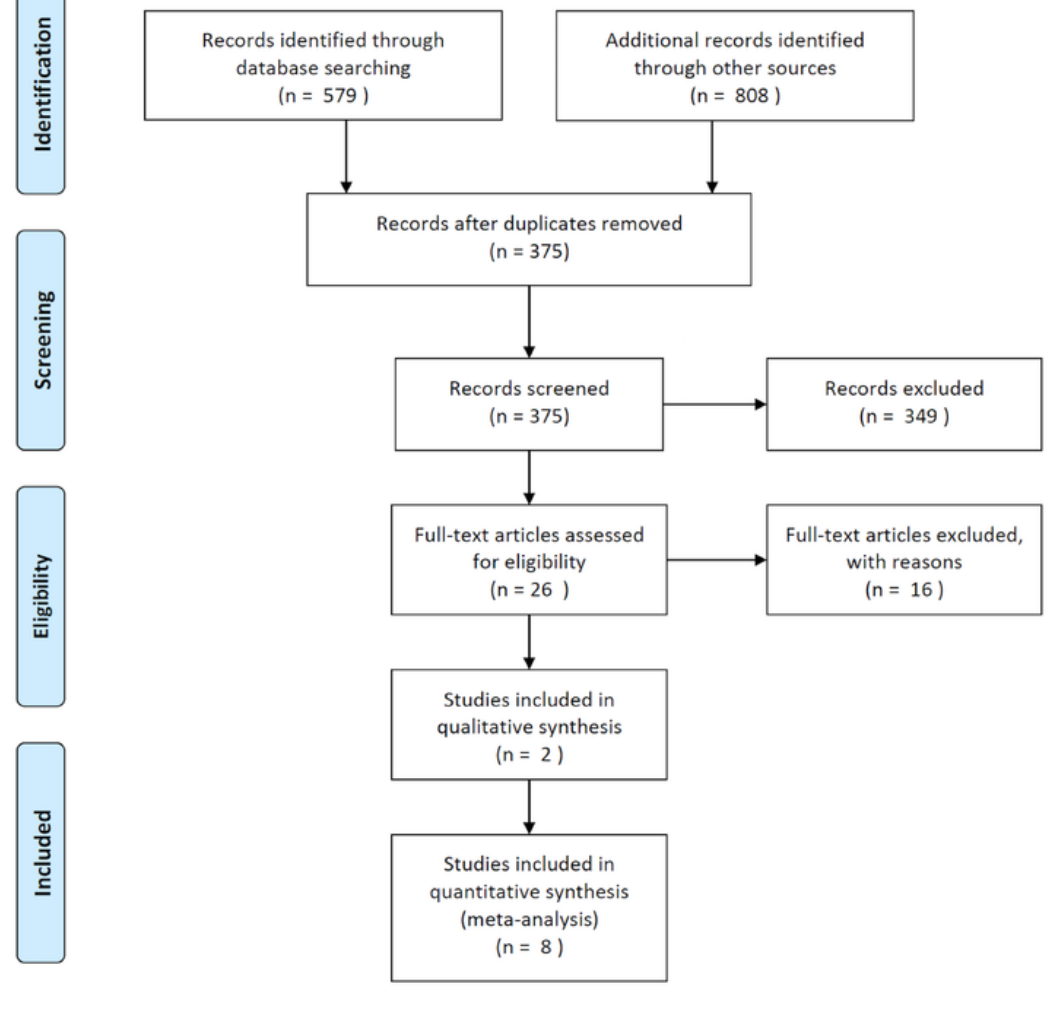
Figure 1. PRISMA flow